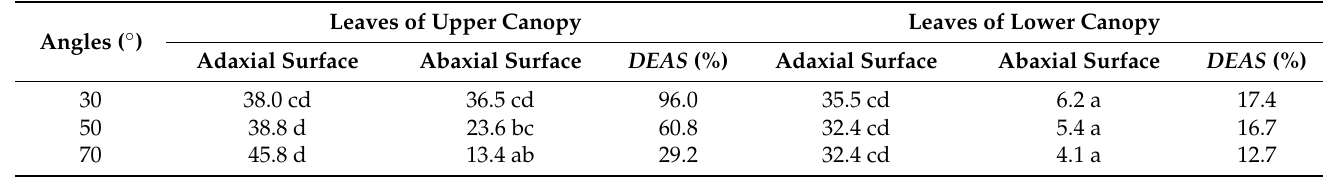
Table 5. Coverage (%) of the leaves and the DEAS values at different spray